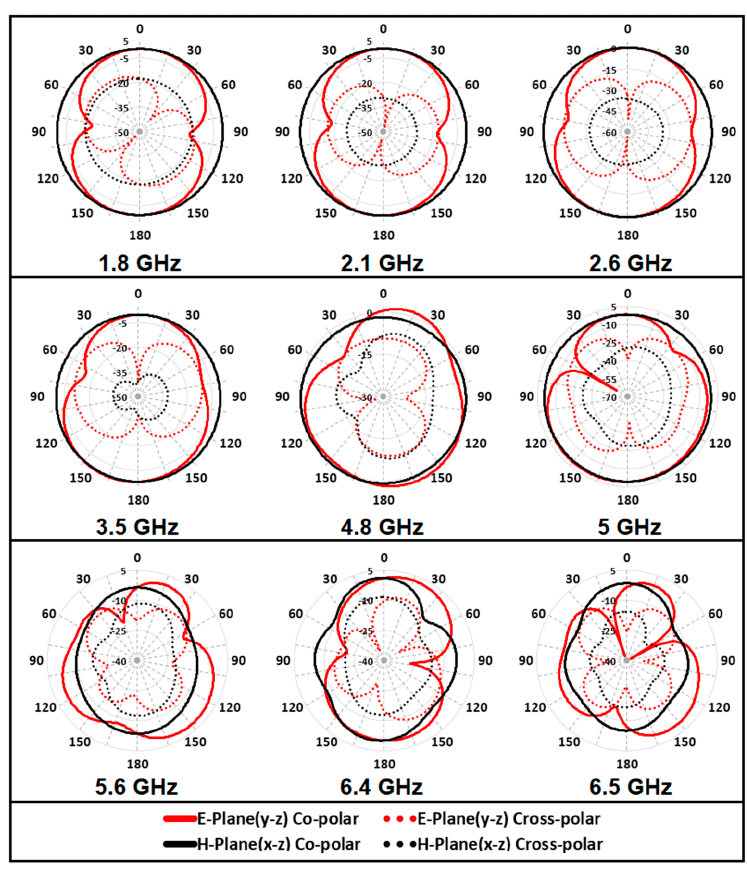
Figure 10. Co- and cross-polar radiation pattern for both principal planes. Figure 10.